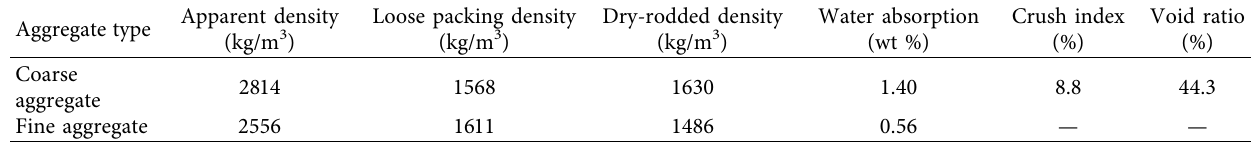
Table 2: Physical properties of the coarse and fine aggregate.